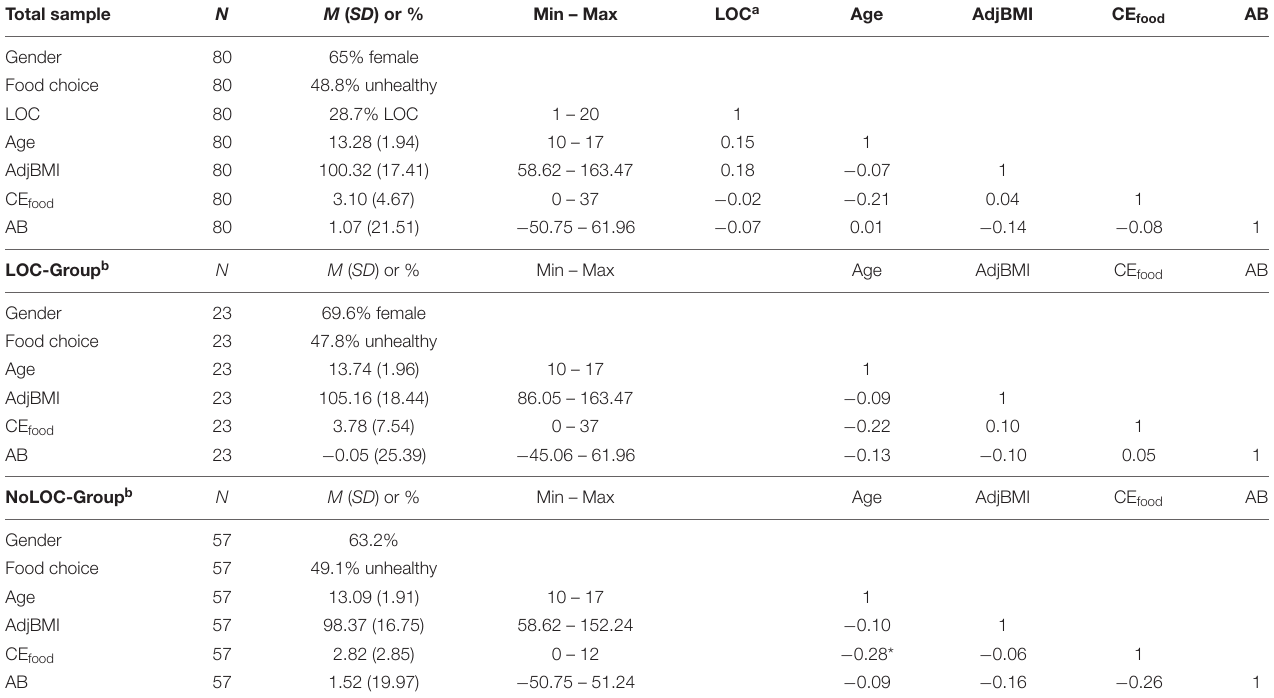
TABLE 1 | Descriptive statistics and